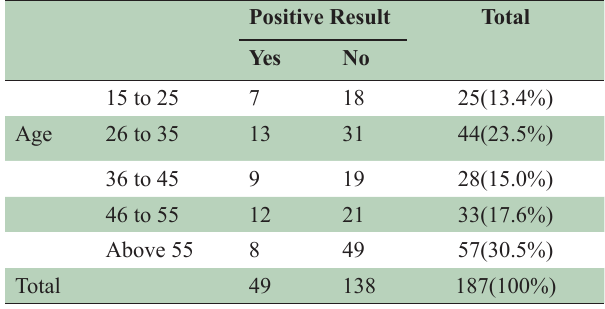
Table-IV: Table of association among the age and Gene Xpert.